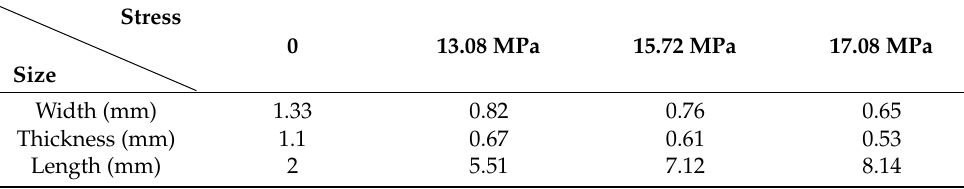
Table 1. Change in TPU sample sizes under different stresses at Nf = 1 × 10 5 cycles.